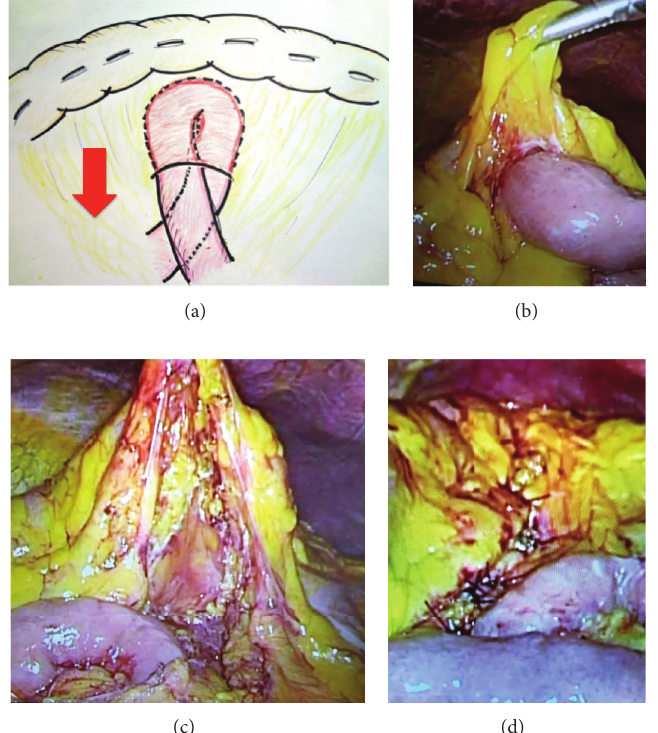
Figure 4: Operative findings . (a) Illustration. (b) The ileum is herniated through the mesenteric defect. (c) The small intestine is pulled out through the mesenteric defect. (d) Closure of the mesenteric